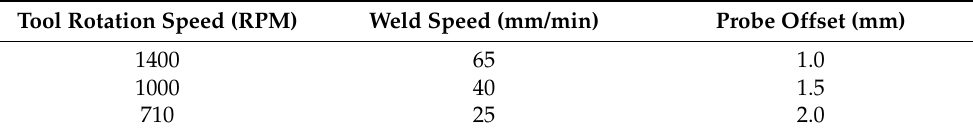
Figure 4. Experimental set-up—linear numerically controlled FSW machine (ETA, WS004). Table 4. Different welding variables.